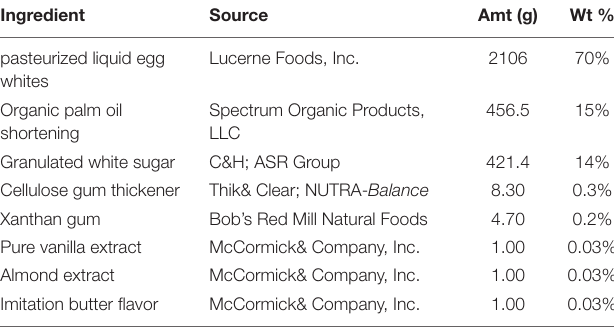
TABLE 1 | A liquid-mixed macronutrient tolerance test